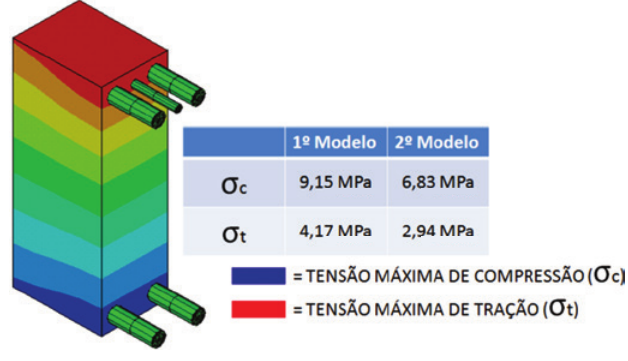
Figura 15 Tensões no concreto na seção de momento